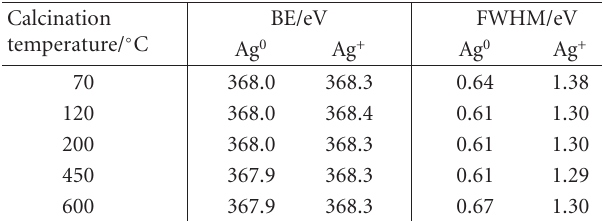
Table 3: Table of Ag 3d 5 / 2 peak positions and FWHM for 1 wt.% Ag-TiO 2 photocatalysts at various calcination temperatures.